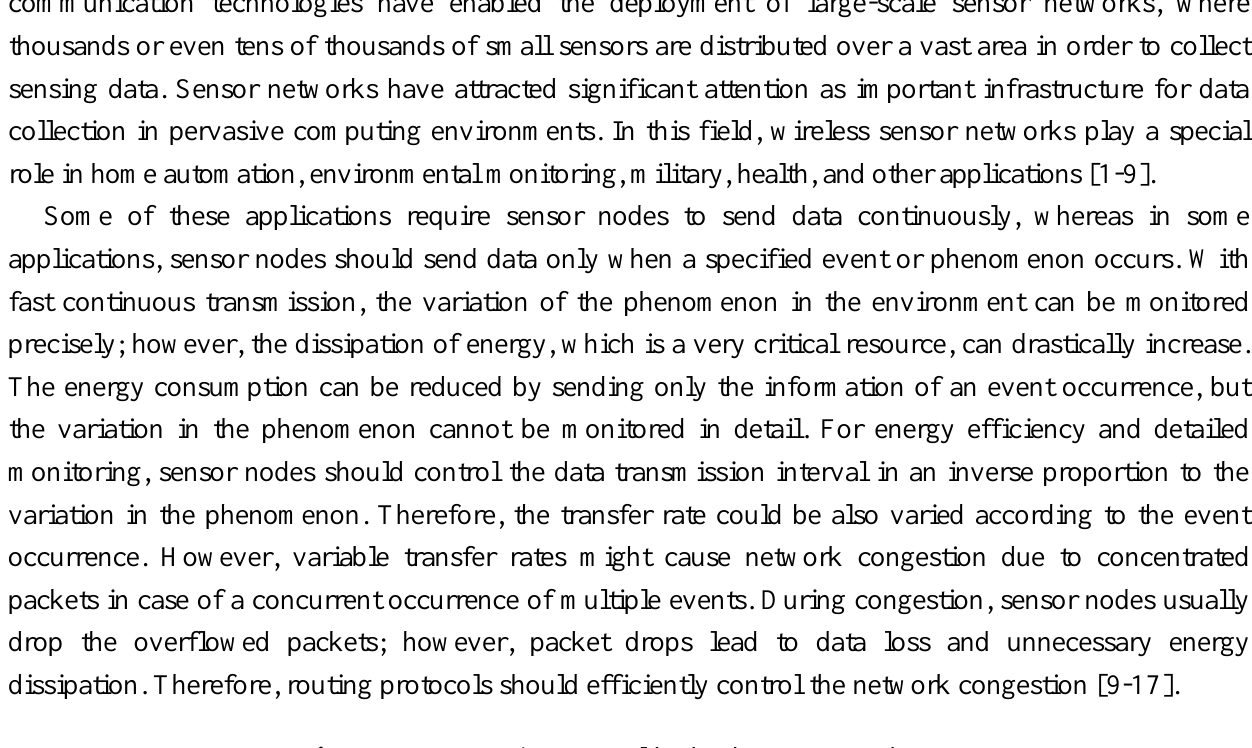
Figure 1. Congestion control by back-pressure